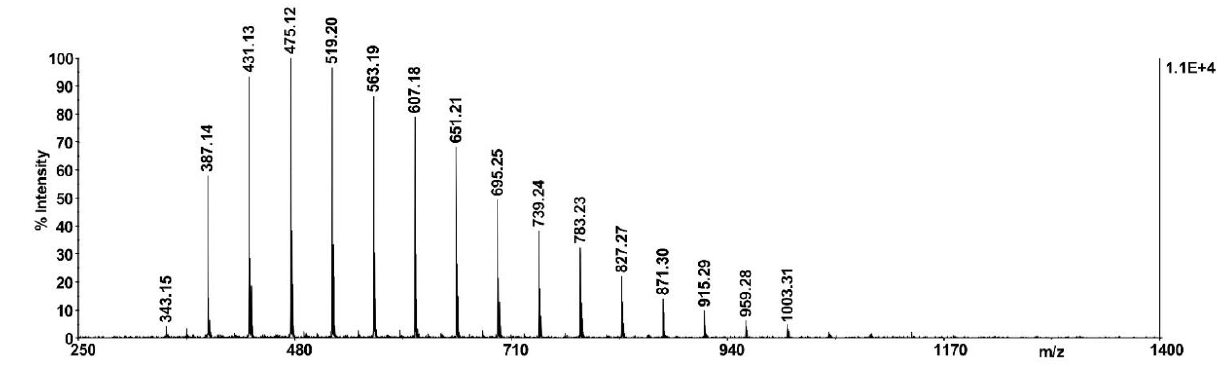
Figure 4. LDI-MS of protonated lignin oligomers.